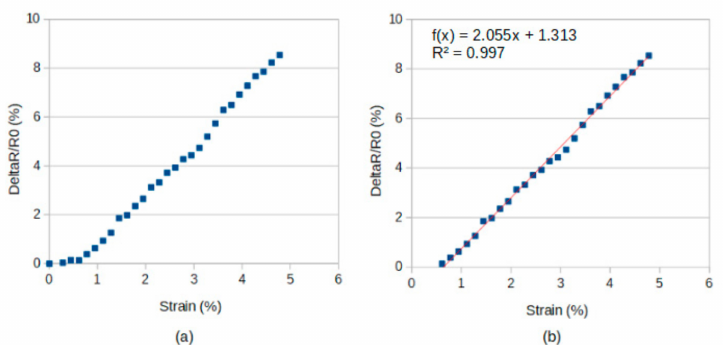
Figure 11. The curve representing the evolution of the resistance as a function of strain for a sensor yarn with 3 layers of piezoresistive coating ( a ) and a focus on the linear part of the curve from 0.61 to 4.78% of strain (linear regression in red), with a gauge factor K = 2.06 ( b